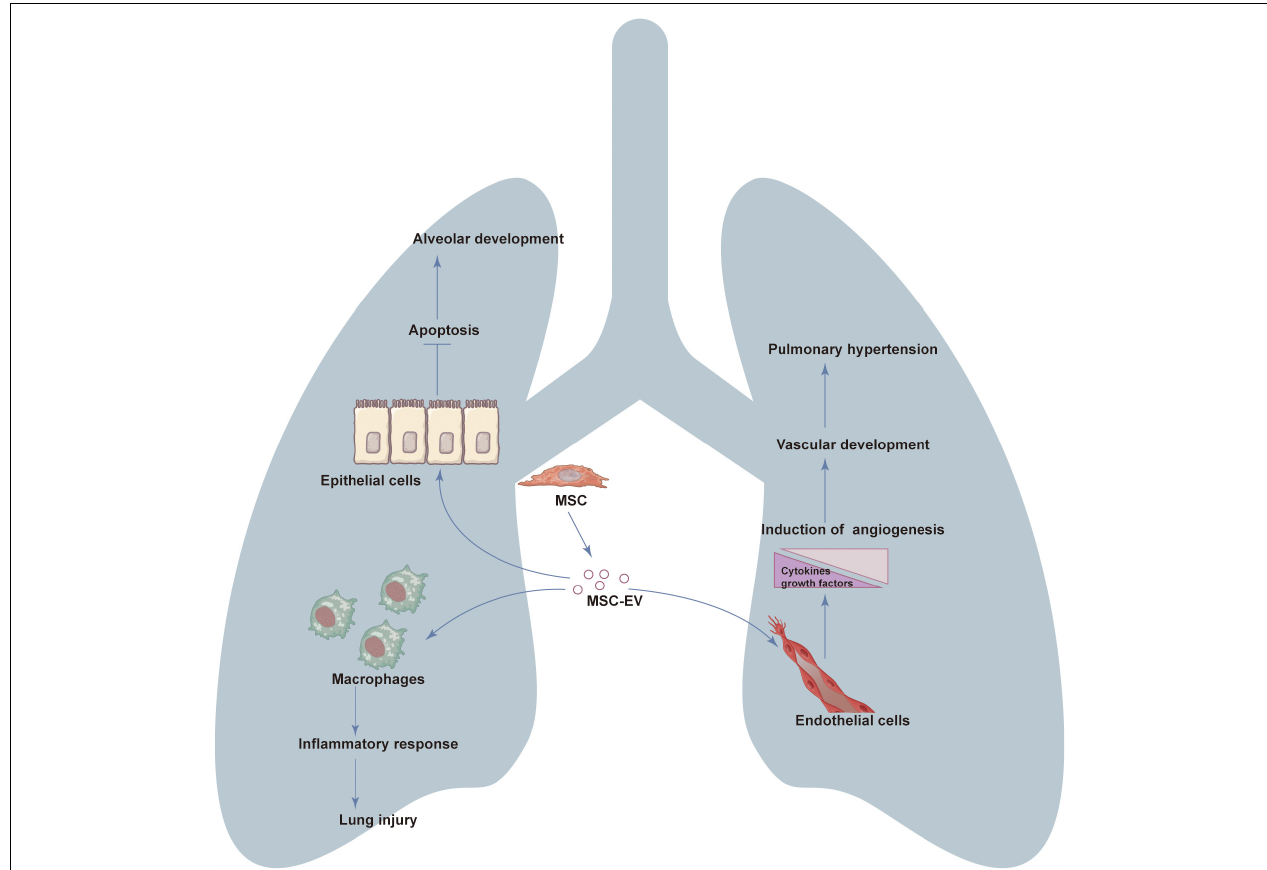
FIGURE 2 | The role of mesenchymal stromal cells derived extracellular vesicles (MSC-EVs) in the treatment of bronchopulmonary dysplasia (BPD). MSC-EVs can promote the development of pulmonary vessels and alveoli and reduce pulmonary hypertension (PH) and inflammation and play an important role in the repair of lung injury in BPD. The regeneration potential of EVs is mainly due to the regulation of cell proliferation, survival, migration, differentiation, angiogenesis, immunoregulation and